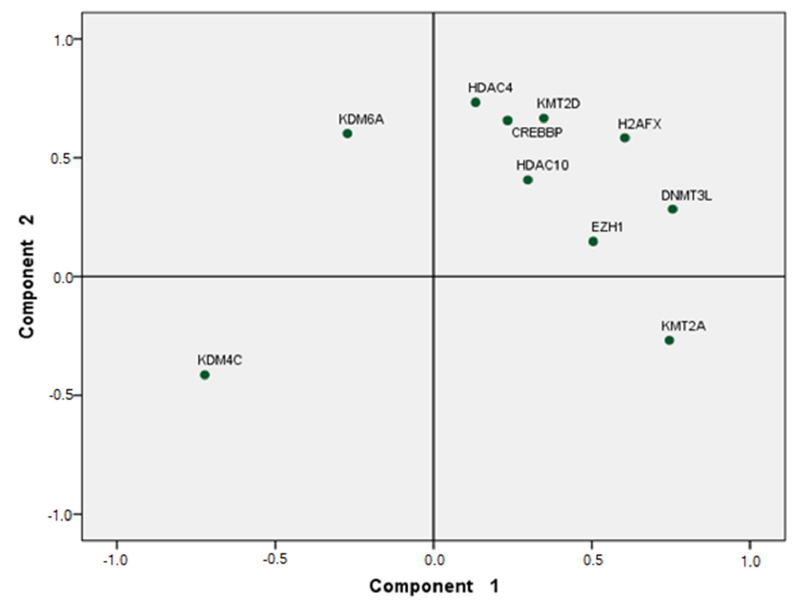
Figure 2. Principal component analysis of pre-training samples with the overexpressed genes found in this study shown as green dots.